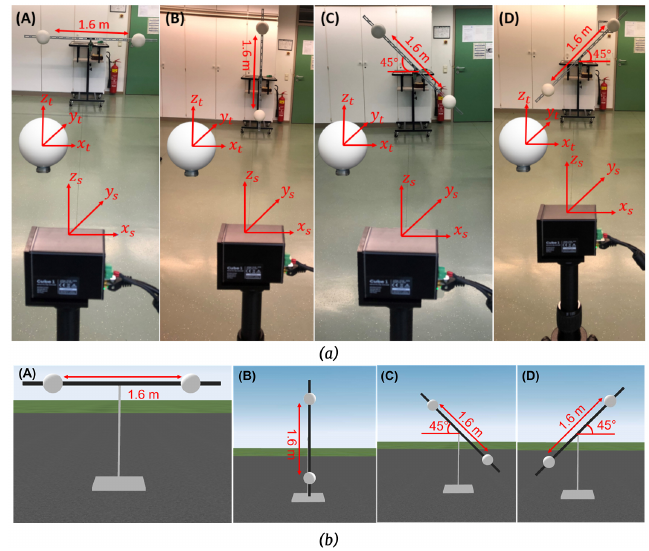
Figure 20. ( a ) Real test setup of symmetric tests for test positions ( A – D ). ( b ) Static simulation scenes of symmetric tests for test positions ( A – D ). The simulated and real sphere targets are placed in front of the sensor approximately at 5.5m. The simulated and real bar length is 2m long, while the distance between the sphere targets is 1.6m. The coordinates of the simulated and actual objects and sensors are the same.